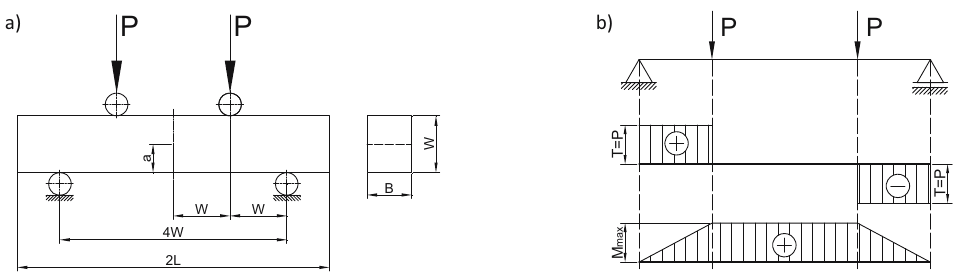
Figure 1: ( a ) Model of a four - point bending beam with a crack with a length of a – SEN ( 4PB ) specimen ( W – specimen width, B – specimen thickness, 2 L – total specimen length, usually amounting to 4.25 · W , P – specimen loading force ) [ 15 ] . ( b ) Distribution of load, shear forces, and bending moment for a four - point bending